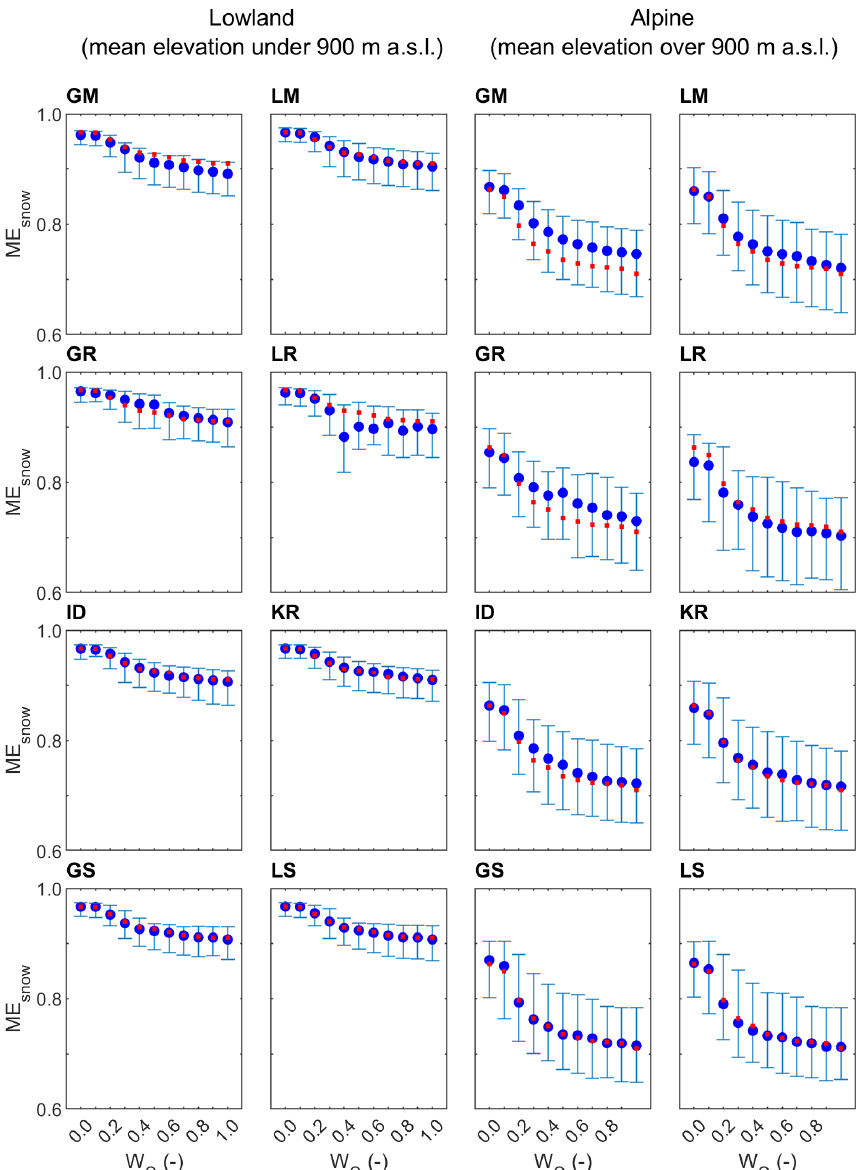
Figure 7. Same as Fig. 6 but for the validation period